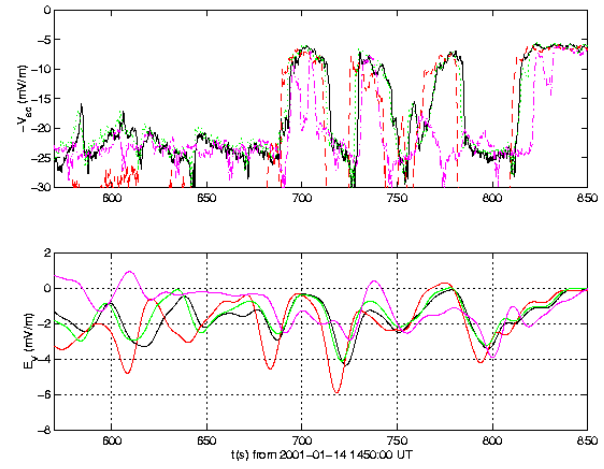
Figure 12. Fig. 12. Spacecraft potential and electric field data. Top panel shows the negative of the satellite potential. The middle panel shows the radial component of the electric field which has been lowpass filtered at 0.1 Hz. There is a data gap around 15:05 UT. The bottom panel shows the spectrogram of the non-filtered electric field.